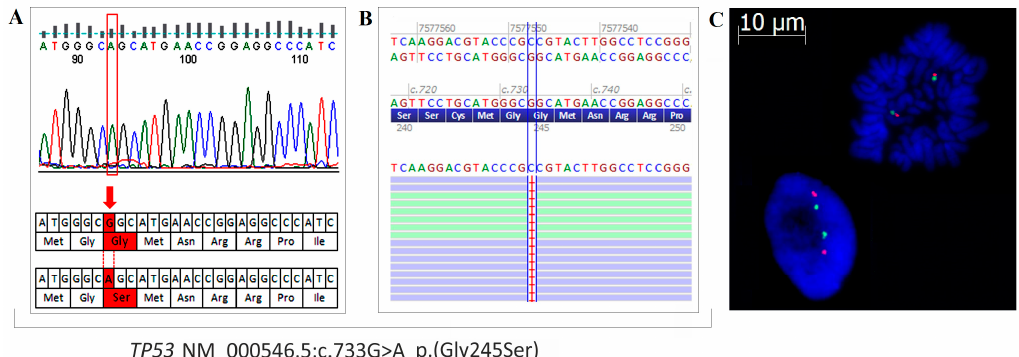
Figure 8. Detection of TP53 mutation in OVPA8 cell line. Sanger sequencing showed homozygous mutation c.733G>A (p.Gly245Ser in OVPA8 cells ( A ). NGS analysis confirmed this result ( B ), FISH analysis showed no numerical changes in chromosome 17 and TP53 signals. Green dots represent the chromosome 17 centromere, while orange dots represent TP53 ( C ) . High-grade serous ovarian cancer frequently presents dysfunction of BRCA genes (either germline or somatic mutations, promoter methylation, and/or loss of heterozygosity). We checked OVPA8 cells for three BRCA1 founder mutations which are most common in Polish population: C61G (c.181T>G; p.Cys61Gly), 4153delA (c.4035delA; p.Glu1346Lysfs), and 5382insC (c.5266dupC;